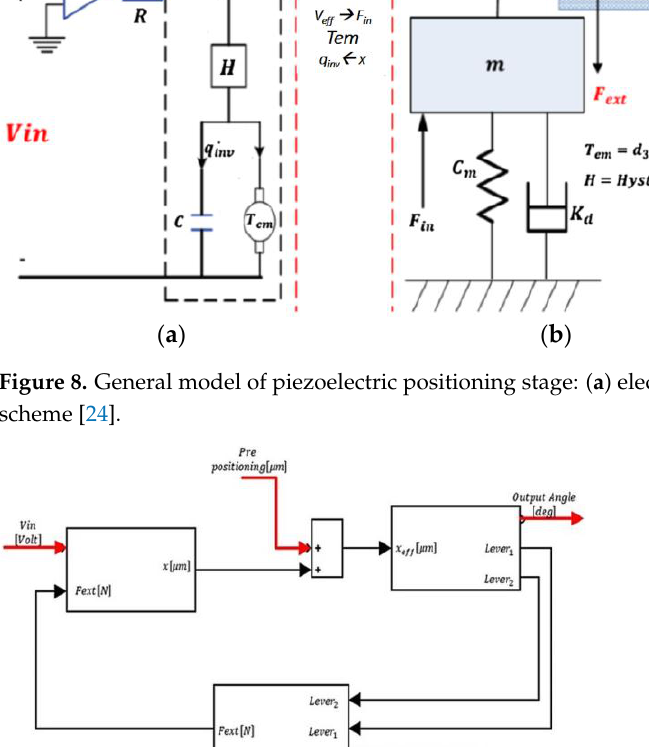
Figure 8. General model of piezoelectric positioning stage: ( a ) electrical scheme and ( b ) mechanical scheme [24].